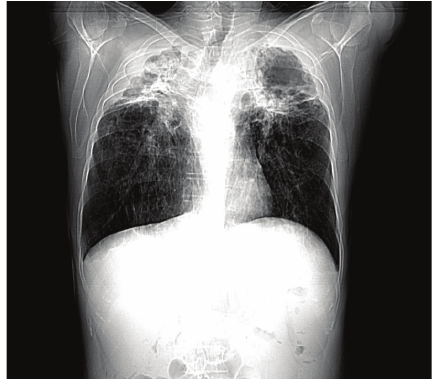
Figure 4: On a CT scan view of the upper lobes cavity lesions are demonstrated, with new shadows inside them, most probably due to aspergillus